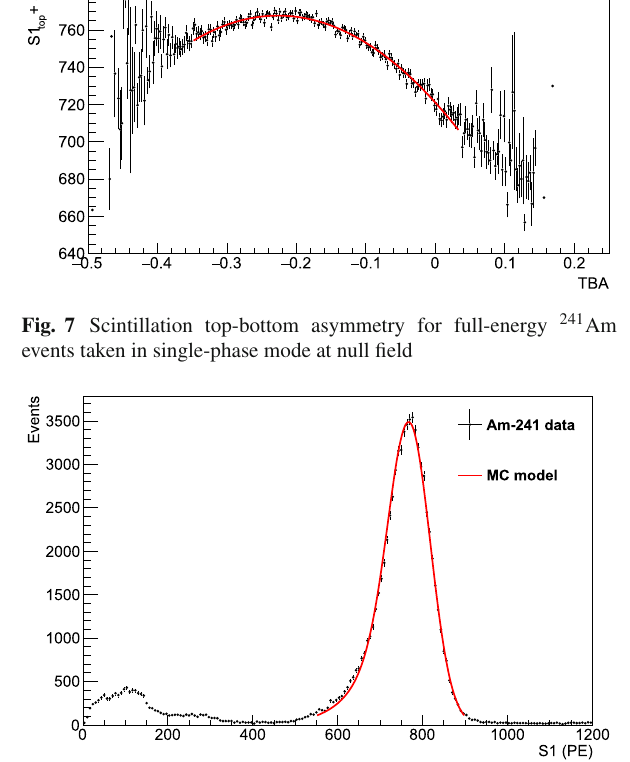
Fig. 8 S1 distribution for a 241 Am measurement taken in single-phase mode at null field, with TBA correction applied. The best fit to the MC model discussed in the text is